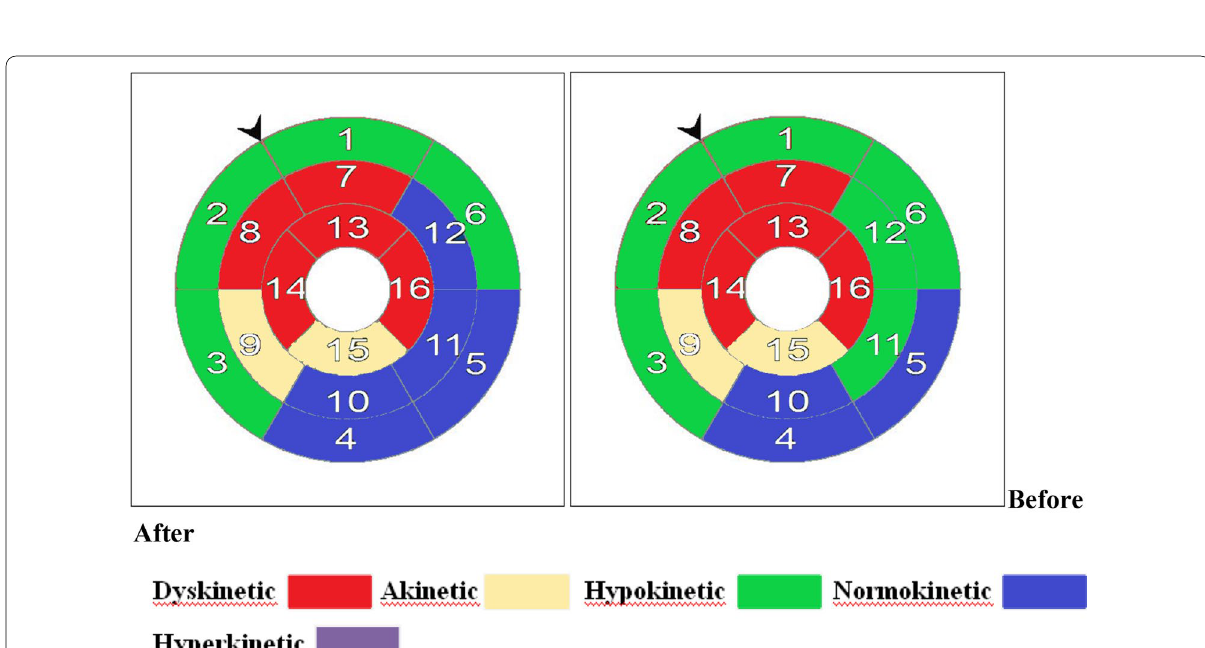
Fig. 3 Patient No. 1 (CG): 59-year-old exsmoker, hypertensive patient with established diagnosis of anterior STEMI underwent primary PCI then enrolled to the CG. By the end of the study there was a deterioration in EF (23 vs.20) % and WMSI (2.4 VS. 2.6) shown by American heart association (AHA) CMR Bull’s eye plot segmental WMS of the left